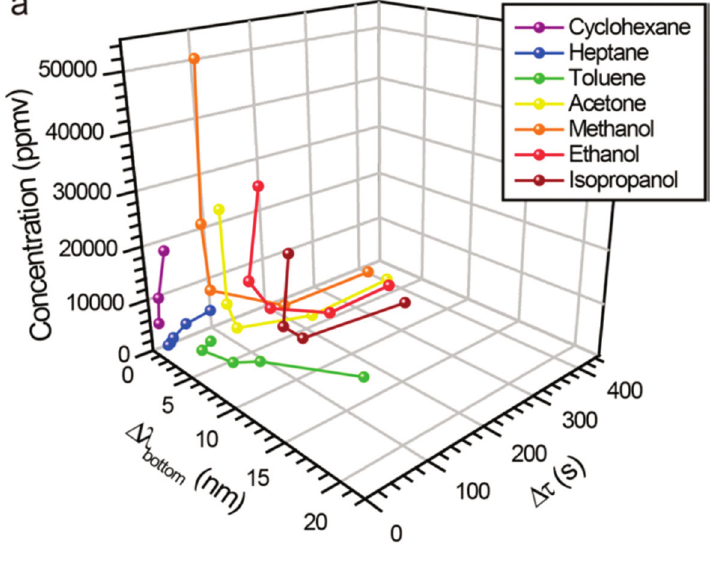
Figure 2. The 3D plot showing the wavelength shift of the photonic stop band of the bottom layer ( Δλ bottom) and the retention time ( Δτ ) as a function of concentration for the seven analytes indicated. Reprinted with permission from Reference [46]. Copyright 2011 American Chemical